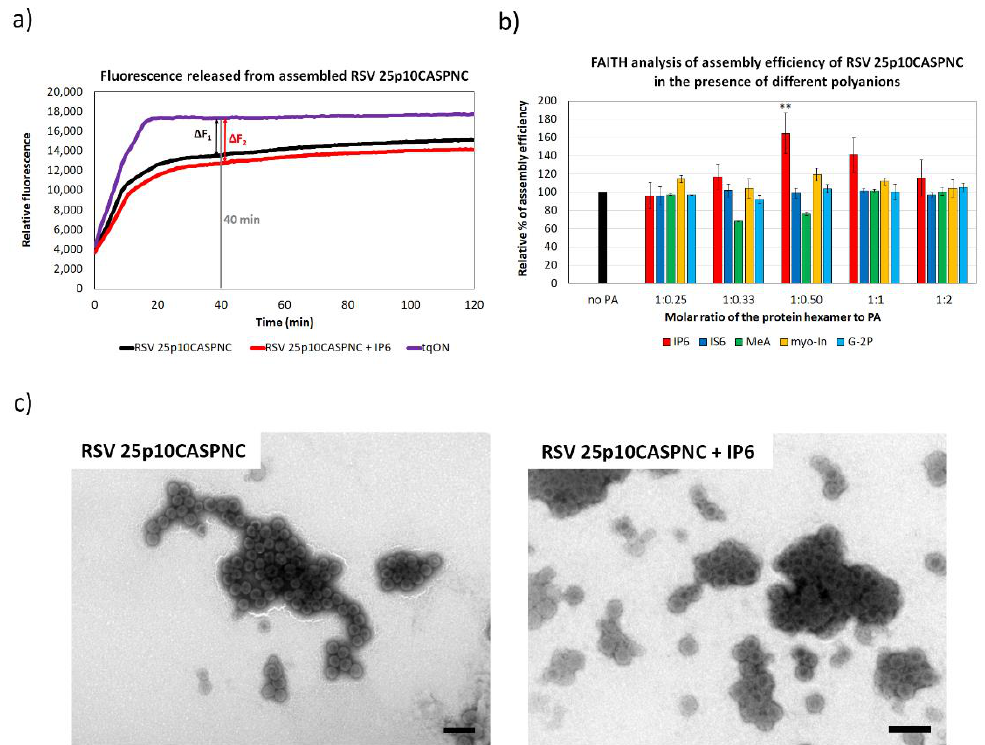
Figure 2. The efficiency of RSV 25p10CASPNC protein assembly in the presence of polyanions. ( a ) Fluorescence emission curve demonstrating the kinetics of degradation of free dual-labeled oligonucleotide (tqON) in the absence (violet curve) or presence (black curve) of RSV 25p10CASPNC: ∆ F1 represents the difference between the relative fluorescence of tqON and tqON in the presence of 25p10CASPNC, and ∆ F2 corresponds to the difference between the relative fluorescence of tqON and tqON in the presence of 25p10CASPNC and polyanions. ( b ) Percentage of assembly efficiency of RSV 25p10CASPNC protein in the presence of different concentrations of IP6 (red), IS6 (royal blue), MeA (green), myo-In (yellow) and G-2P (azure blue) at indicated ratios of the protein hexamer to IP6. p -values were assessed by ANOVA using the Tukey–Kramer test (**, p < 0.01). ( c ) TEM images of negatively stained RSV 25p10CASPNC protein assembled in the presence of tqON in the absence or presence of IP6 at final concentration 1.1 µ M (the ratio of the protein hexamer to IP6 was 1:0.5). Bars represent 200 nm.